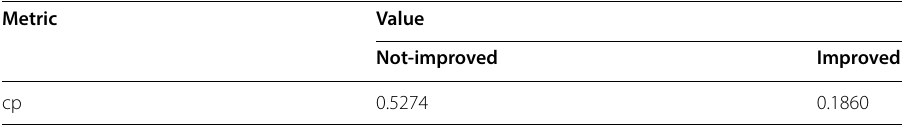
Table 4 Workflow improvement analysis Metric Value